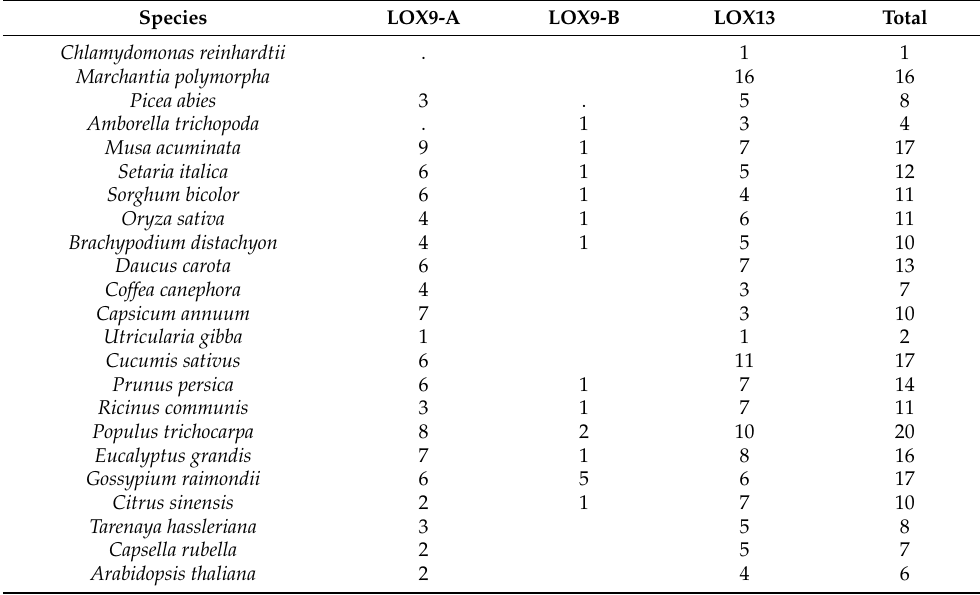
Table 1. Species used for LOX analysis. Fourteen species of eudicots, five species of monocots, and four basal species were